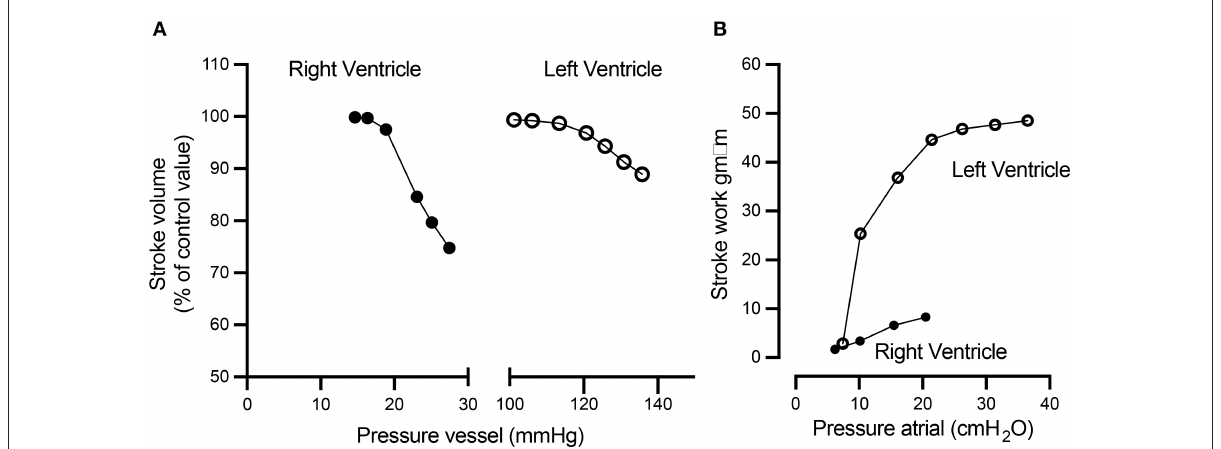
FIGURE2 The RV and LV respond differently to increased afterload and preload. (A) Compared to the LV, with a 10 mmHg afterload difference (between 20 and 30 mmHg), the RV displays a rapid decline in the stroke volume, while the LV remains relatively stable. Conversely, (B) the LV stroke work rapidly increases as the preload increases, while the RV stroke work response is more modest to similar preload changes. This figure was published in: Braunwald (24). Reproduced by permission from Braunwald (24).